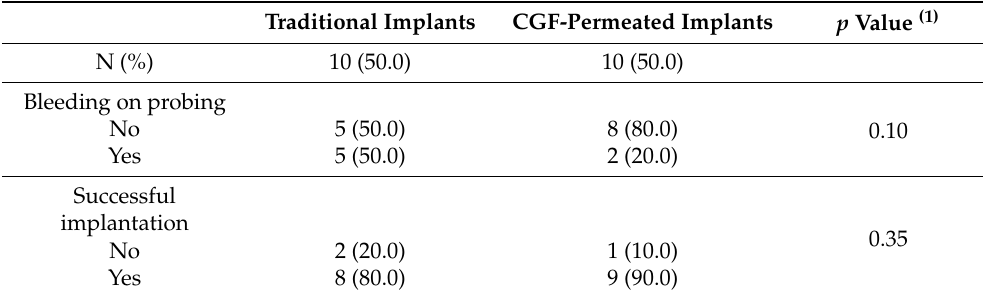
Table 1. Post-operative course for traditional and CGF-permeated implants. Traditional Implants